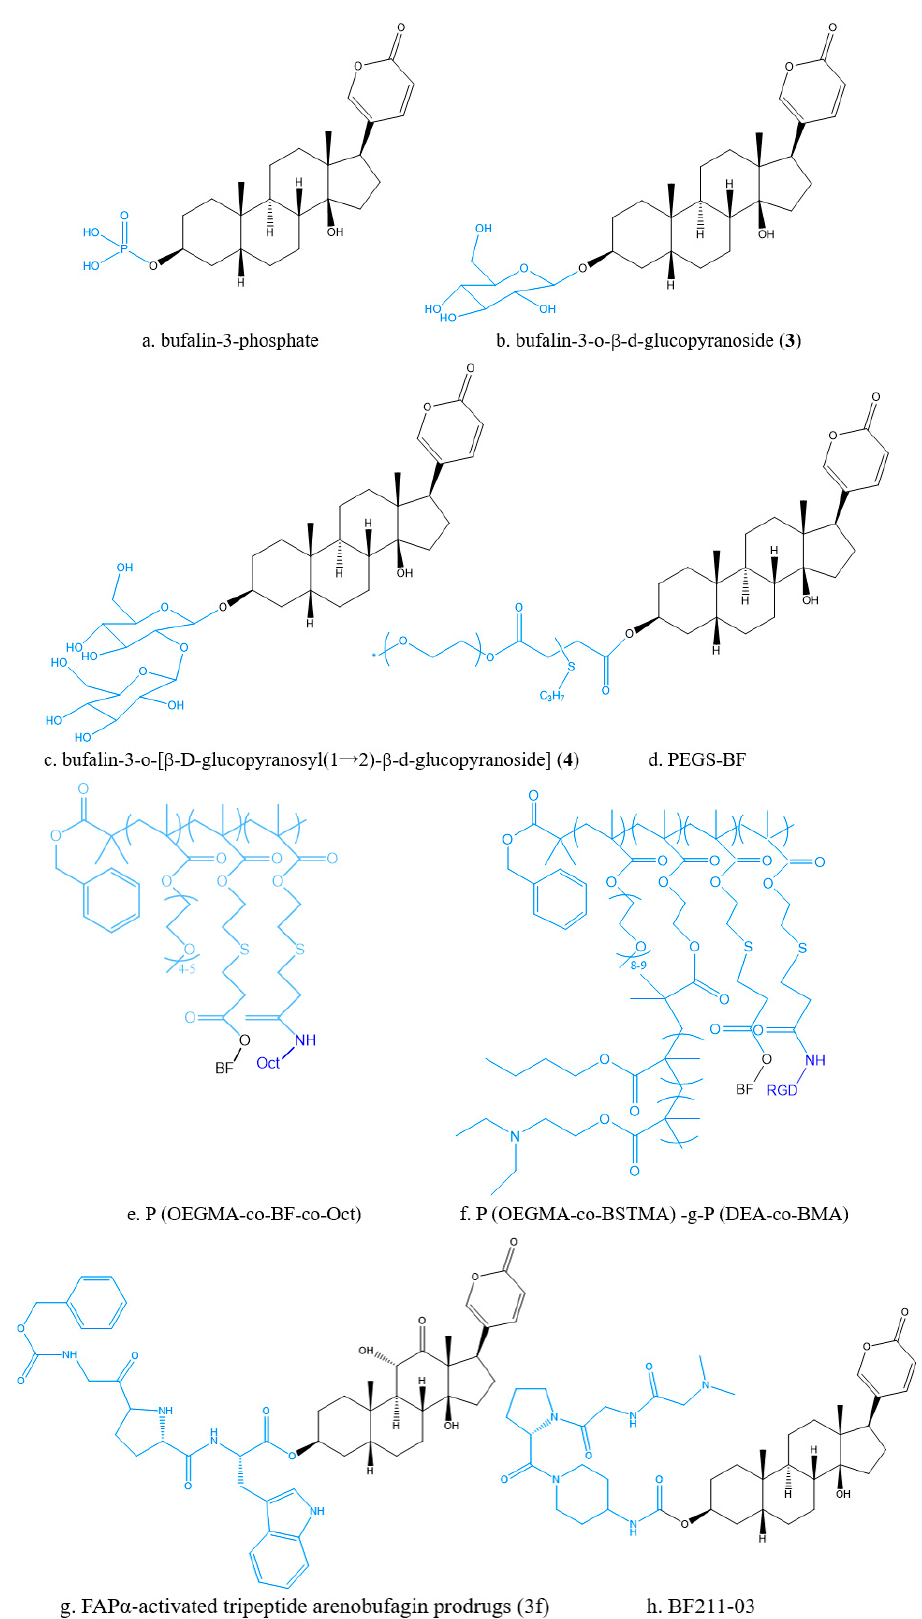
Figure 7. The prodrugs of bufadienolides.